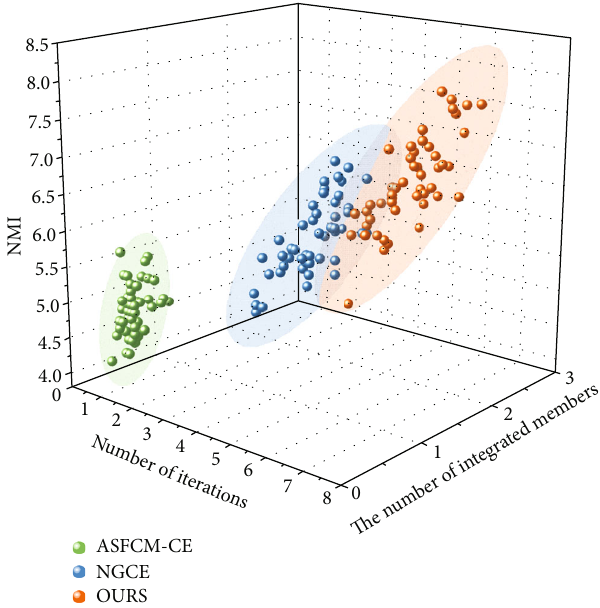
Figure 6: E ff ect of the number of integrated members on the clustering